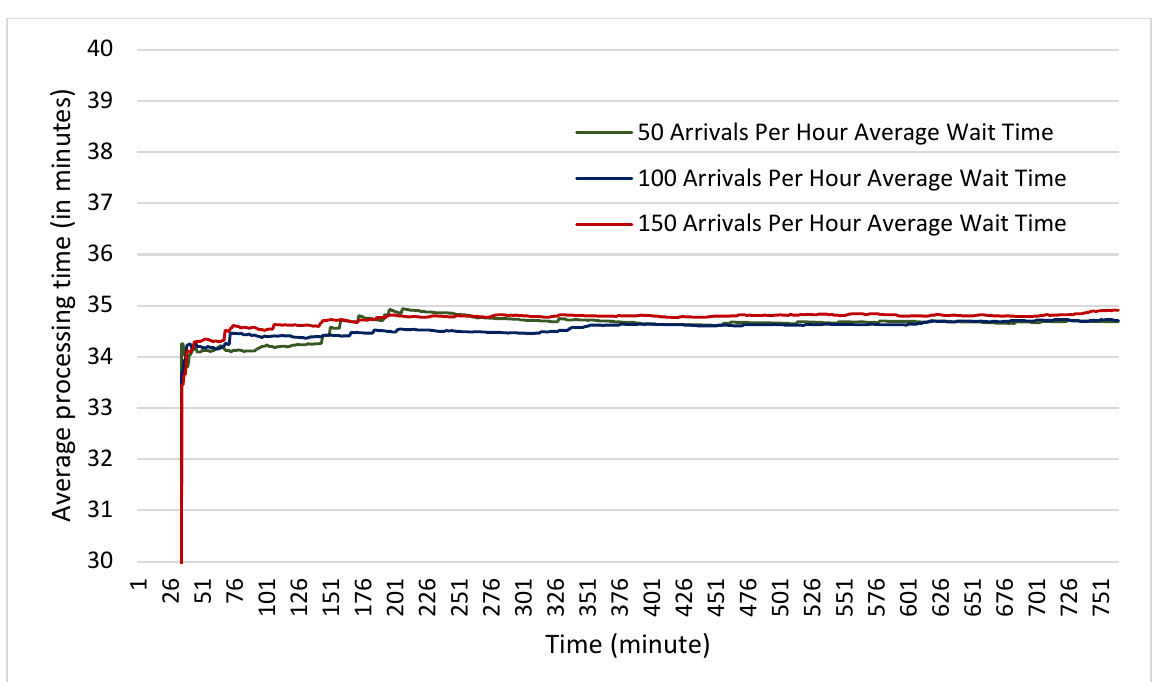
Figure 6. Average time spent waiting by clients at each of the arrival rates for a facility with physical distancing measured in minutes. As far as wait times are concerned, minimum and average times spent in the clinic were nearly the same in all scenarios (see Figure 7). All average times were 34 min except one (150 arrivals per hour with physical distancing), which had a mean of 35 min. This trend was repeated for the maximum time spent in the clinic with all non-physical distancing scenarios, and the first two physical distancing scenarios all displaying maximum times between 49 and 51 min. The outlier of this trend is the scenario with 150 arrivals per hour and physical distancing measures in place, which showed a maximum time of 70 min. It is not entirely clear why this scenario had a noticeably longer wait time. One possible answer is that the delay was due to a situation where several clients went to exit the facility at once, a process which was slowed by physical distance measures in place.